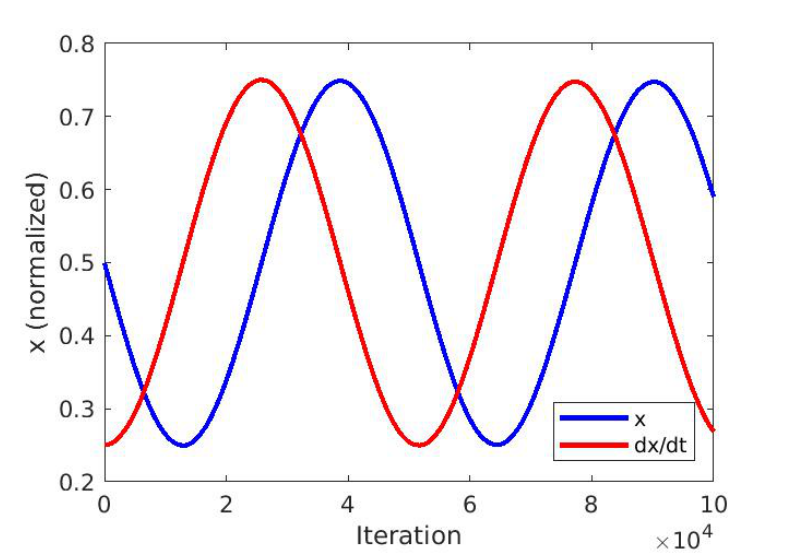
Figure 7. Output of the scheme in Figure 6, showing both x and ˙ x . In this case, N acc = 16, N = 18 bits, resulting in a ∆ t = 1/8192